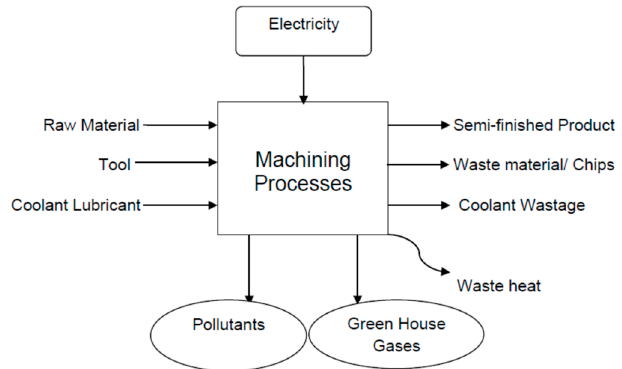
Figure 2. Initial workpiece and finished product diagram of a milling/turning process.